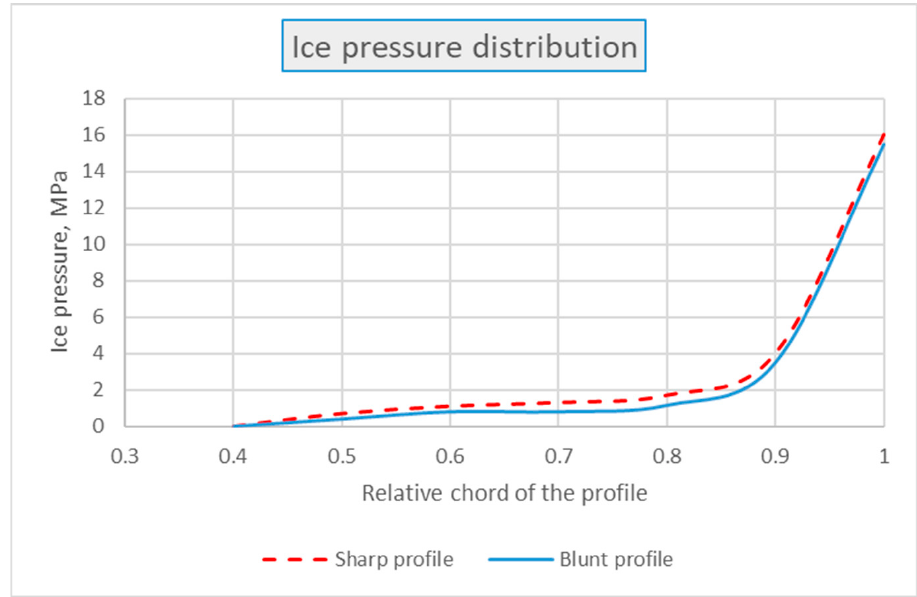
Figure 4. Ice pressure distribution for icebreaker profile and IK82 profile (blunt profile) [7]. Shear stresses are characterized by the regularities listed above.